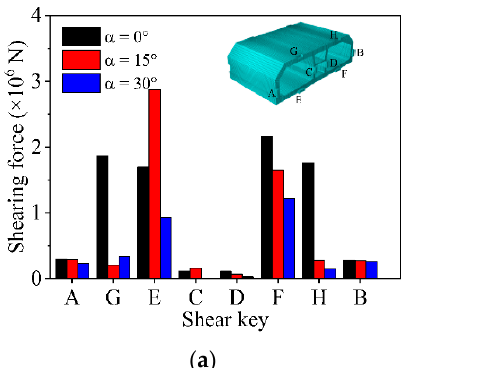
Figure 22. Tensile stress vector diagram of the shear key: ( a ) shear key B; ( b ) shear key E. (unit: Pa)